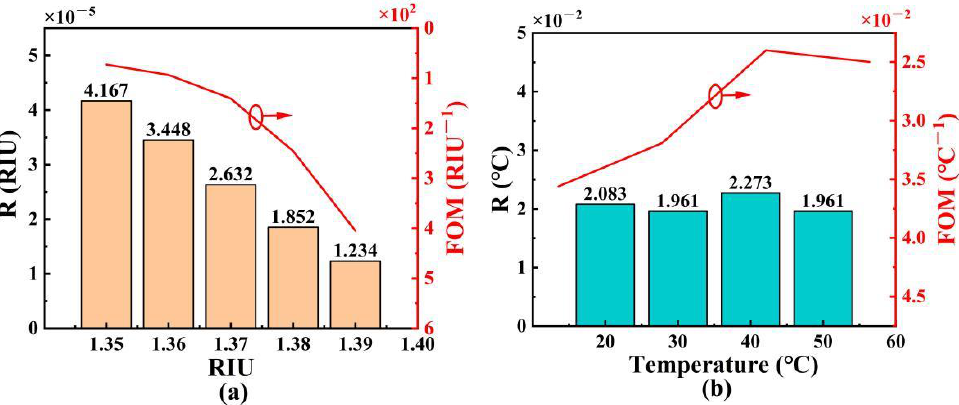
Figure 12. The R and FOM of the proposed SPR-based PCF sensor with the changes of RI ( a ) and temperature ( b ).